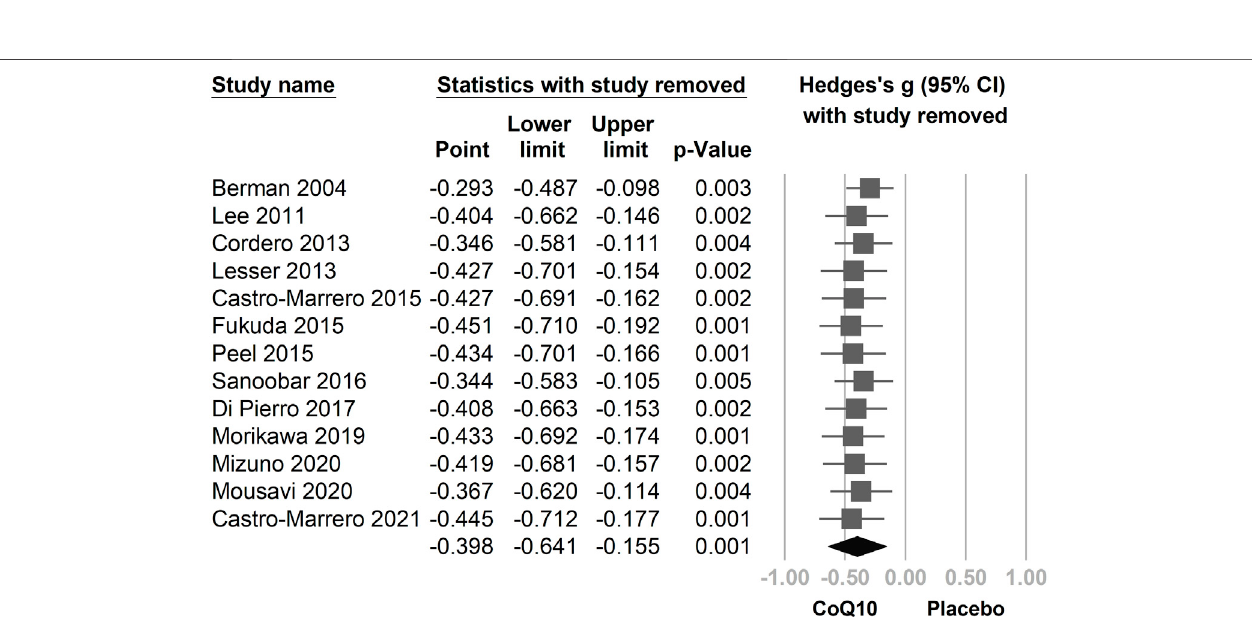
Frontiers in Pharmacology |